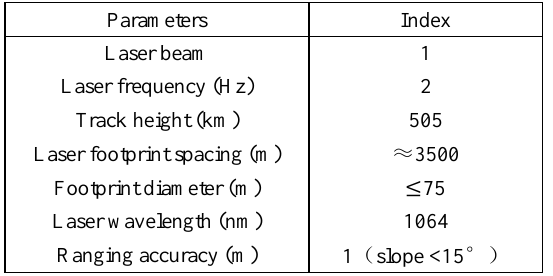
Table 1. ZY3-02 laser altimeter technical parameters.